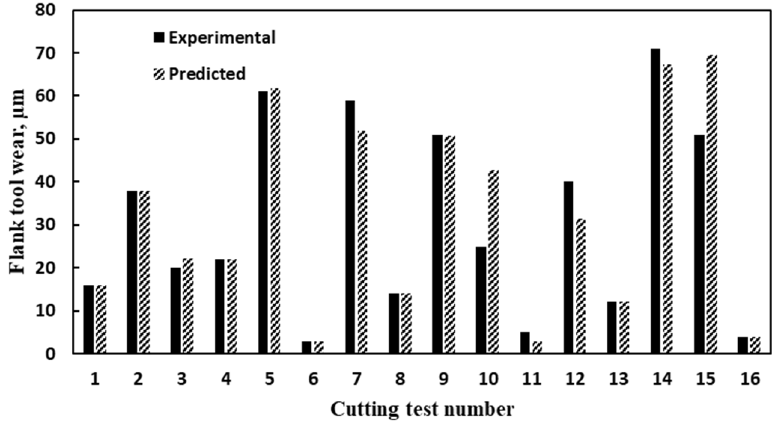
Figure 7. A Comparison between experimental and predicted flank tool wear.